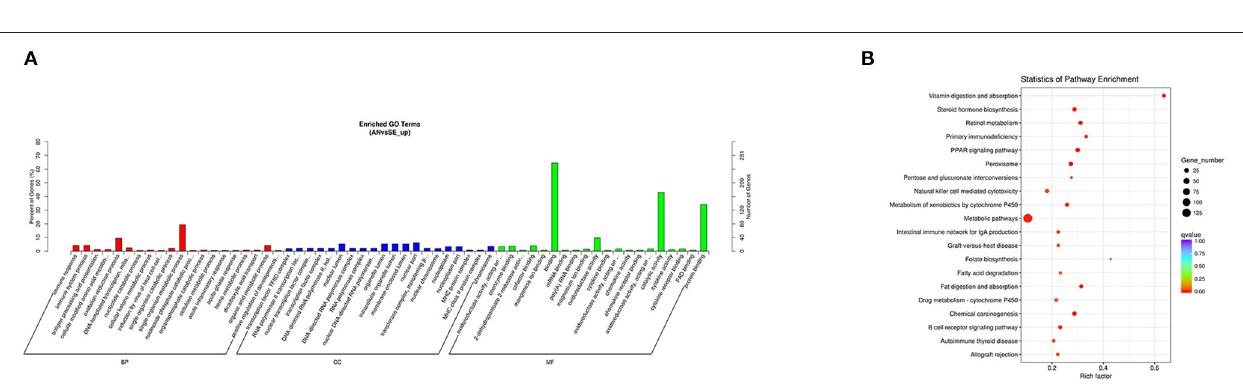
FIGURE 6 | Top annotated GO terms (A) and KEGG pathways (B) of cis-target genes of upregulated DE lncRNAs.